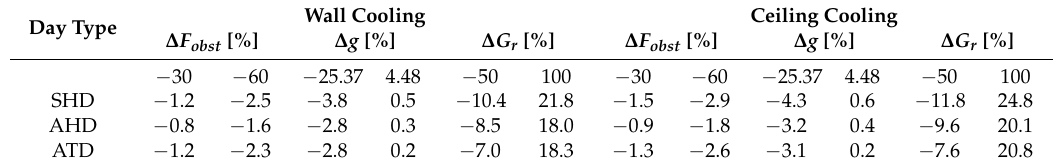
Table 5. Variation of the heat load for East orientation of the facade [%].